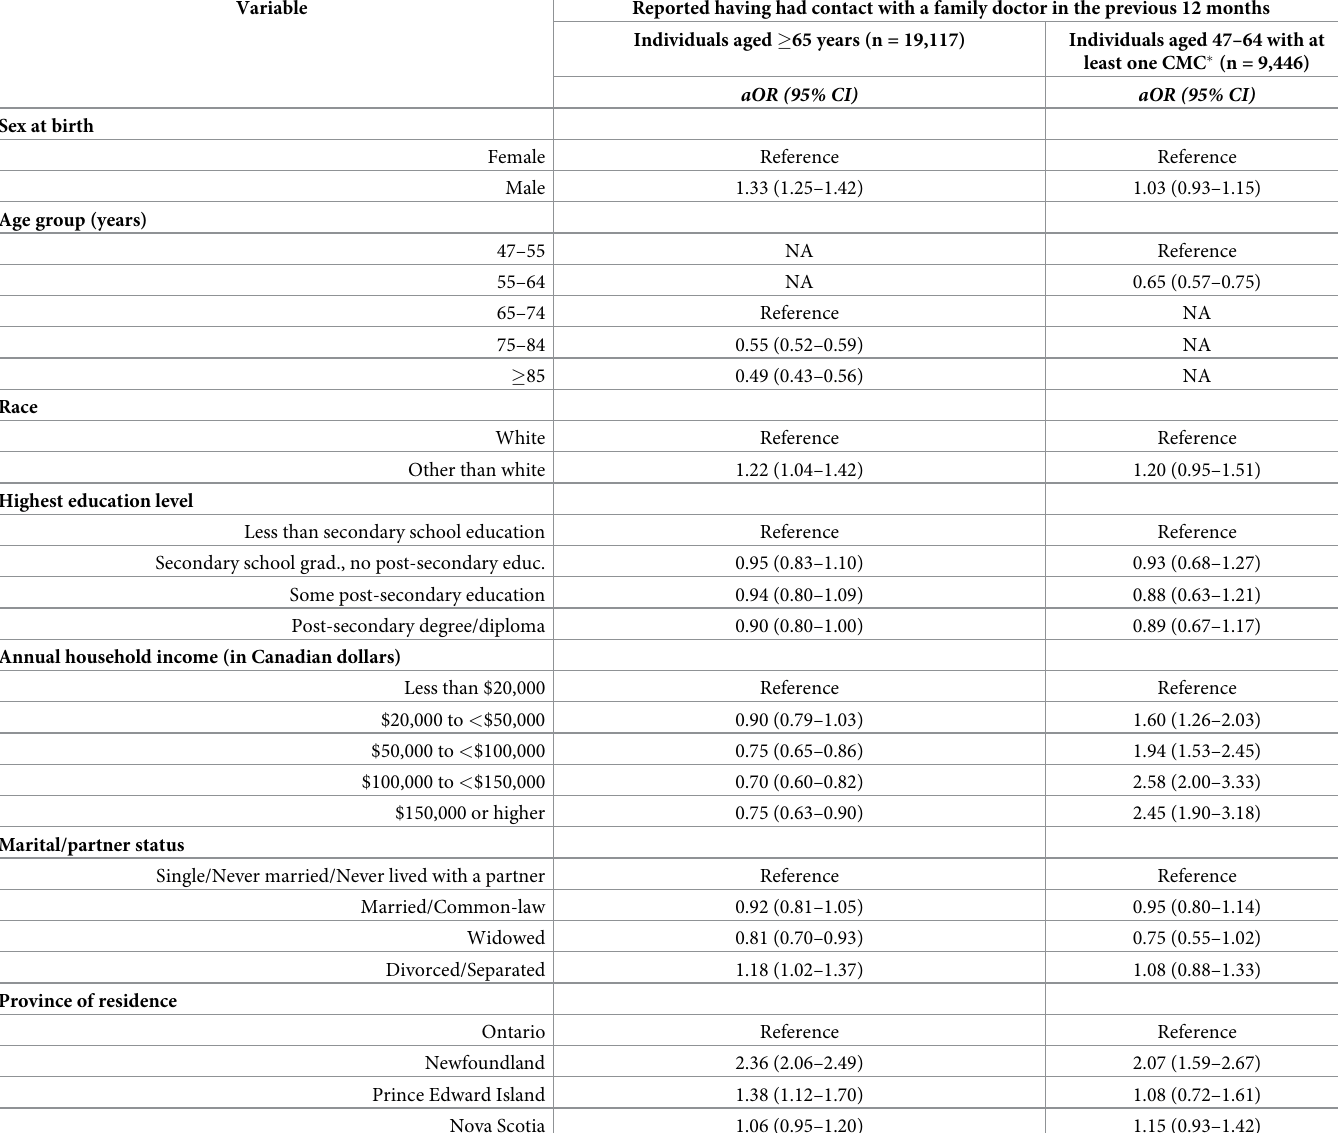
Table 3. Factors associated with missed opportunity for pneumococcal vaccination among CLSA participants aged � 65 years and those aged 47–64 with at least one of select chronic medical conditions (CMC) � who reported having had contact with a family doctor in the previous 12 months.